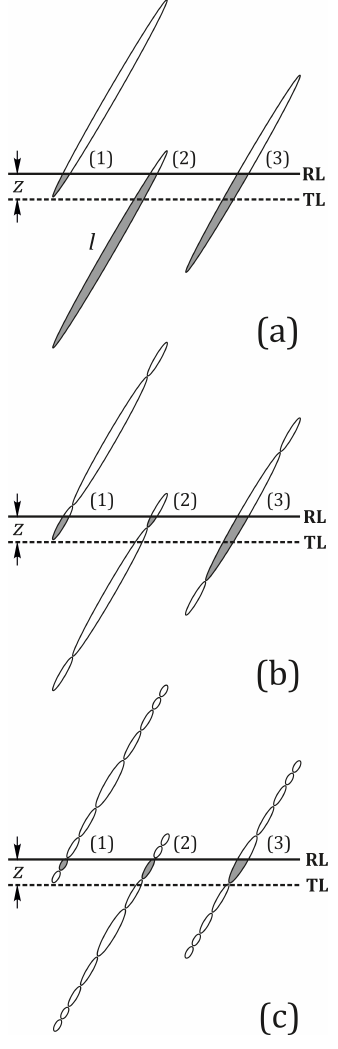
Figure 8. The effect of break-up of fission tracks due to the ap- pearance of unetchable gaps in the course of progressive anneal- ing on the number of tracks counted using transmitted (TL) and reflected (RL) light. We assume for the purpose of illustration that all the tracks that intersect the surface are counted in reflected light but only those that reach at least a depth z below the surface have enough optical contrast to be counted in transmitted light. (a) Con- tinuous tracks: the RL count is proportional to the mean track length l (ignoring anisotropy), while the TL count is low by a fraction pro- portional to ( z/l ), which varies little with l . (b) Initial break-up: there is no loss of tracks in RL; (1) short tracks invisible in TL re- main invisible, but (2) some long tracks can no longer be etched over a sufficient distance from the surface to be visible in TL; (3) if their longer central segments intersect the surface they continue to be counted in TL; the corresponding sections in the grain interior contribute most to the mean confined-track length. (c) Advanced annealing and break-up: the shortest sections remain countable in RL, but none reaches far enough below the surface to be counted in TL. The sketch does not aim to depict the actual dimensions or proportions of etched fission